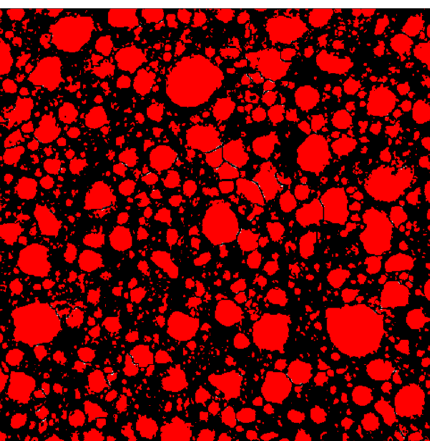
Figure 3. Cross section of NAAC after Image ‐ Pro Plus software processing.